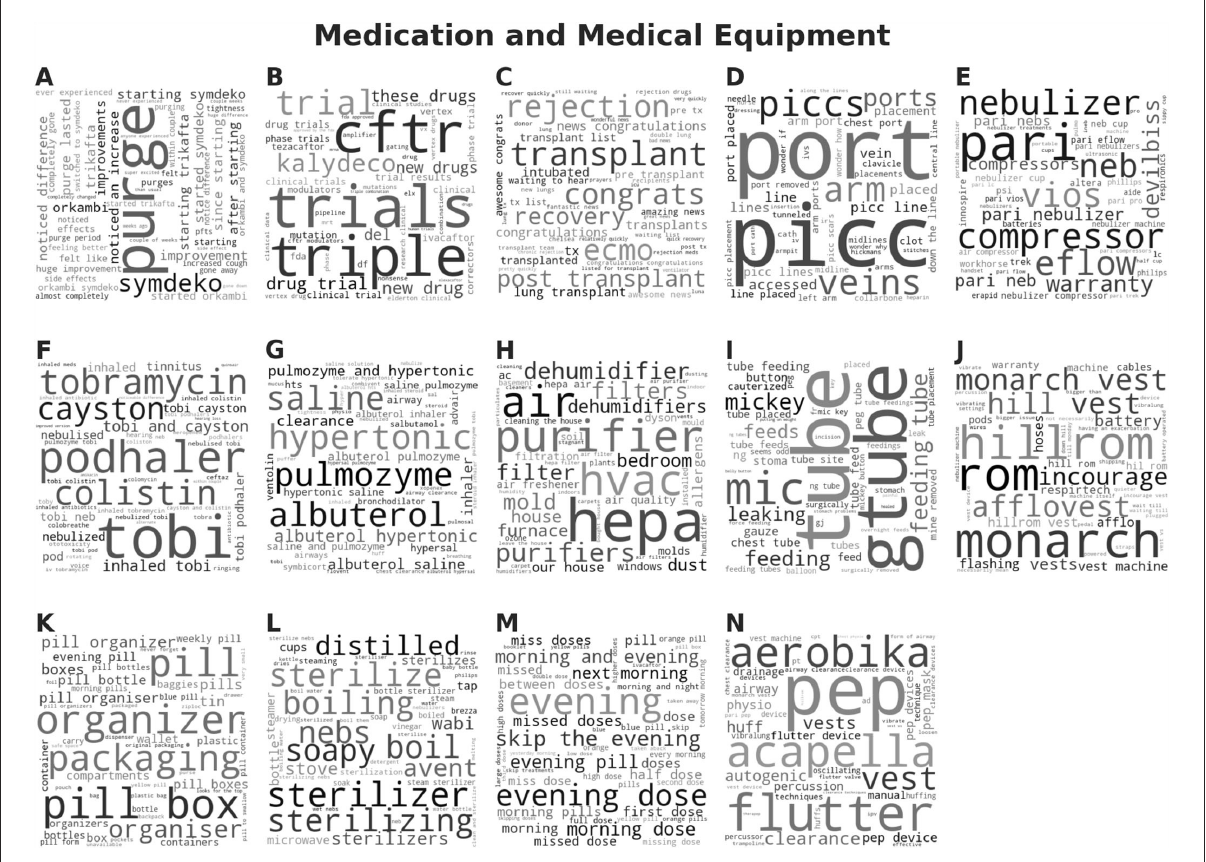
FIGURE5 Word clouds for the topics that were grouped into the medication and medical equipment category for the Top2Vec model using doc2vec embedding. Topics related to “Medication and Medical Equipment” in include: (A) oral drug use, (B) drug trials, (C) transplantation, (D) intravenous medication, (E) nebulizers, (F) inhaled antibiotics, (G) inhaled drugs, (H) air quality devices, (I) feeding tubes, (J) high-frequency chest wall oscillators, (K) pill organization, (L) sterilization, (M) medication dosing, and (N) airway clearing devices, which are main drug category and medical equipment CF patients use and care